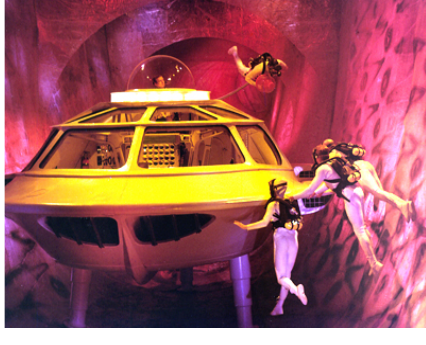
Figure 1. Snapshot in the movie (1966) “Fantastic Voyage” (miniaturized shuttle and crew navigate the human